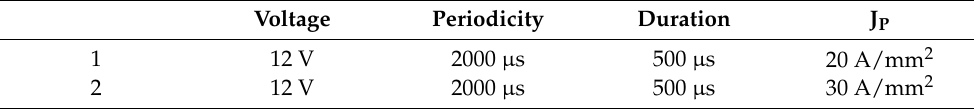
Figure 2. ( a ) Tensile specimen size; ( b ) schematic diagram of the electropulsed treatment assisted tension device. Table 1. The current parameters.